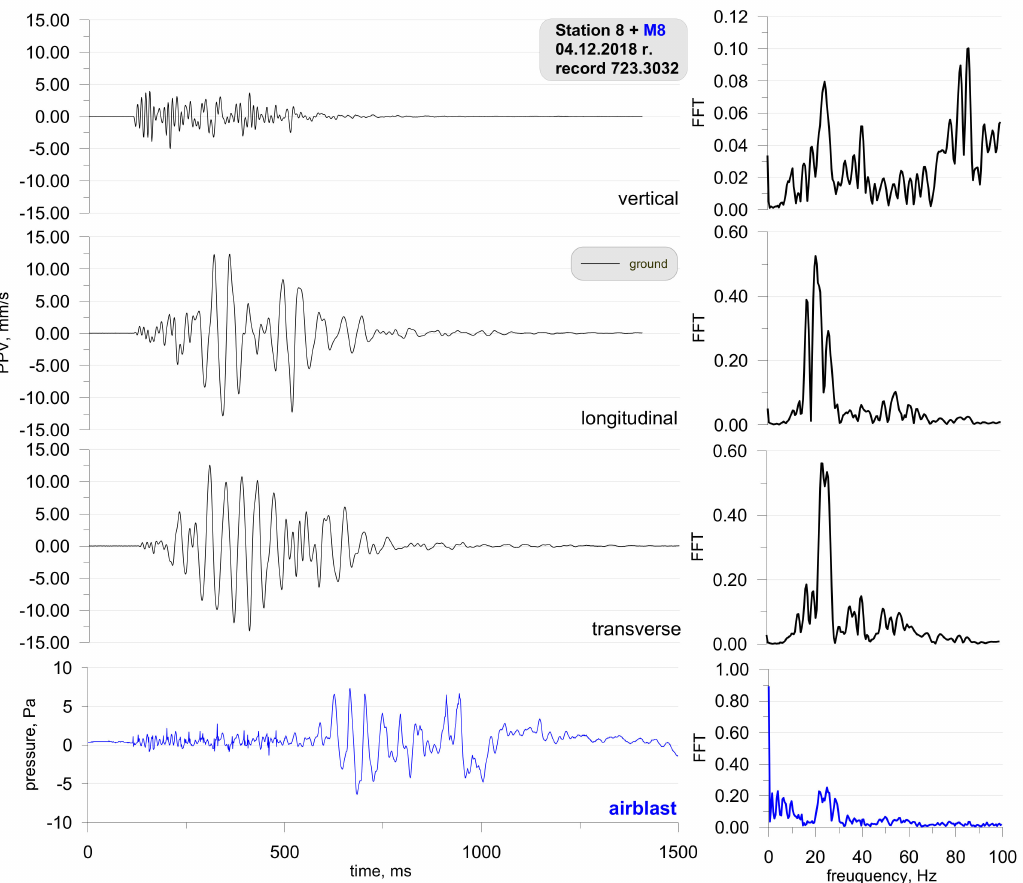
Figure 9. Ground vibration seismogram (three directional components) and recordings of the airblast wave pressure combined with the analysis of the FFT-Station